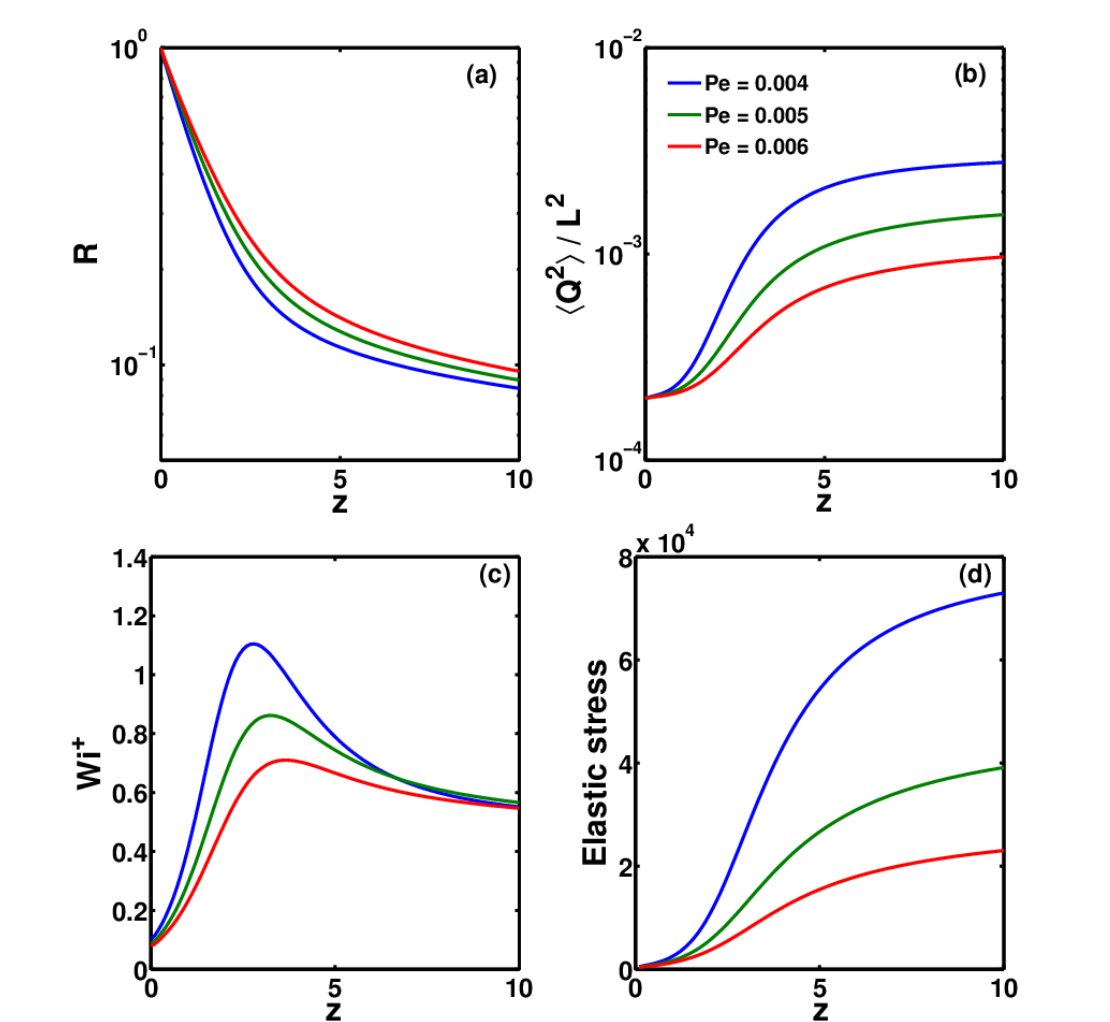
Figure 9. Variation of ( a ) R, ( b ) (cid:104) Q 2 (cid:105) / L 2 , ( c ) Wi + and ( d ) elastic stress as a function of z , for three polymer solutions with different Pe